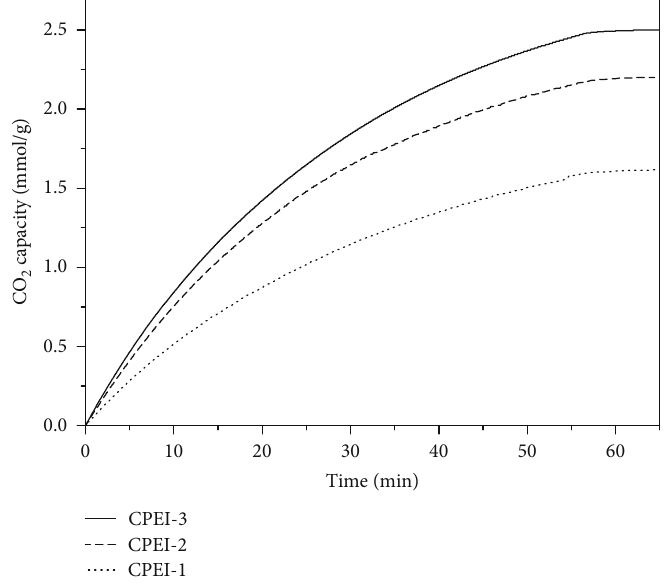
Figure 5: CO capacity of CPEI-1, CPEI-2, and CPEI-3 at 80 ° C and 2